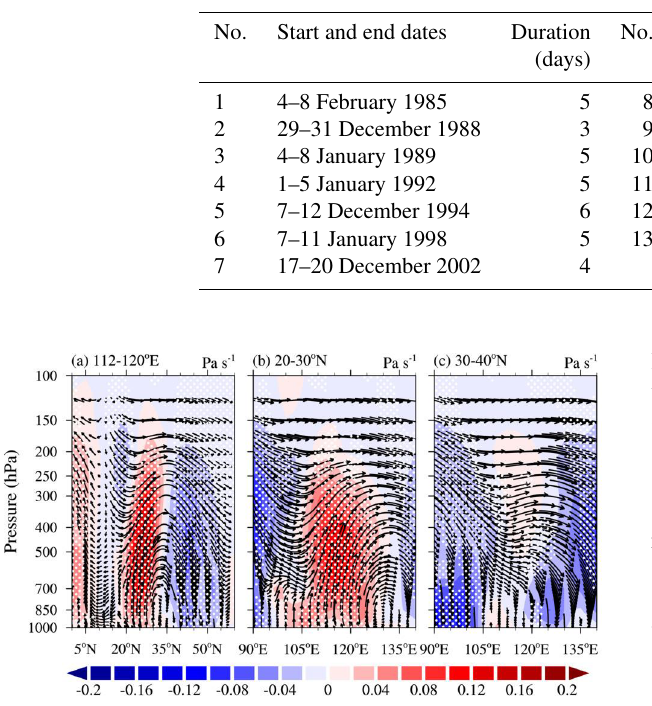
Figure 6. Composite sections of absolute values for the 13 SR– NH events: latitude–height sections of (a) vertical velocity (shading, unit: − 1Pas − 1 ) and wind vectors ( v and − ω ) averaged over 112– 120 ◦ E, and longitude–height cross sections of (b) vertical velocity (shading, unit: − 1Pas − 1 ) and wind vectors ( u and − ω ) averaged over 20–30 ◦ N, and (c) 30–40 ◦ N. Dotted white regions indicate ar- eas at the 99% confidence level based on the two-tailed Student t